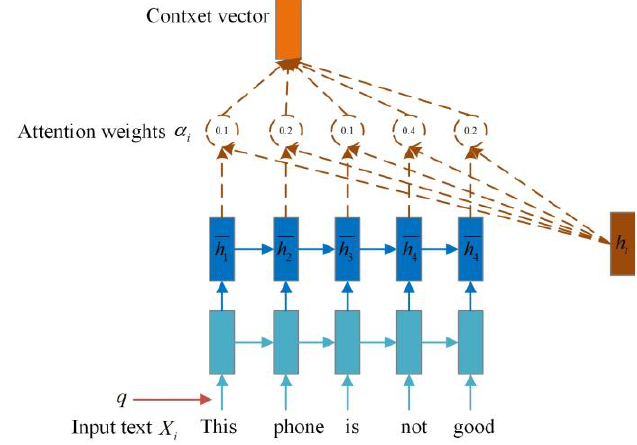
Figure 1. The computational process of the attention mechanism. The attention mechanism consists of three steps: text input, calculation of the attention weight coefficient α , and weighted average of input information.